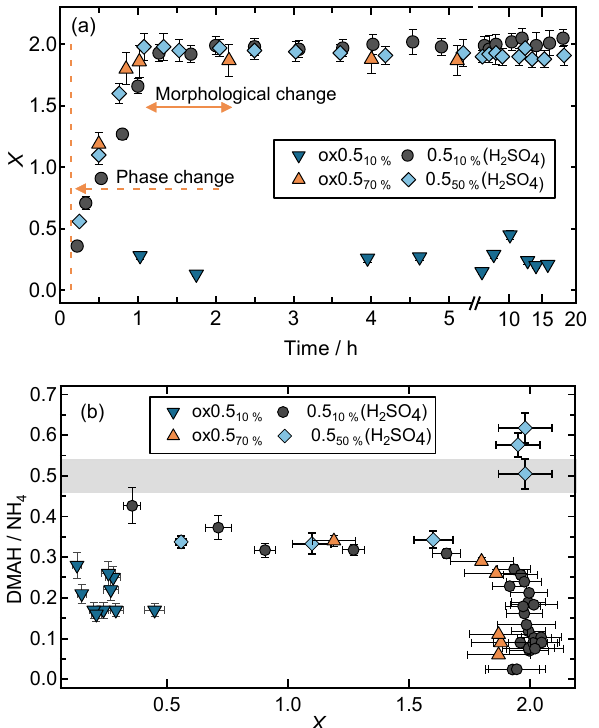
Figure 8. DMA–NH 3 co-uptake at DMA / NH 3 gas molar ratios of 0.5 (Table 1) into sulfuric and oxalic acid particles at 10, 50 and 70% RH. (a) Neutralisation ratios as a function of time. The verti- cal dotted line indicates that the majority of oxalic acid particles at 70% RH underwent phase transition from liquid to solid; the verti- cal solid line indicates the morphological transformation of oxalic acid particles from a non-crystalline to a crystalline morphology at 70% RH. (b) DMAH / NH 4 ratios as a function of particle neutral- isation ratio; the shaded area indicates the gas phase molar ratio of DMA / NH 3 (including